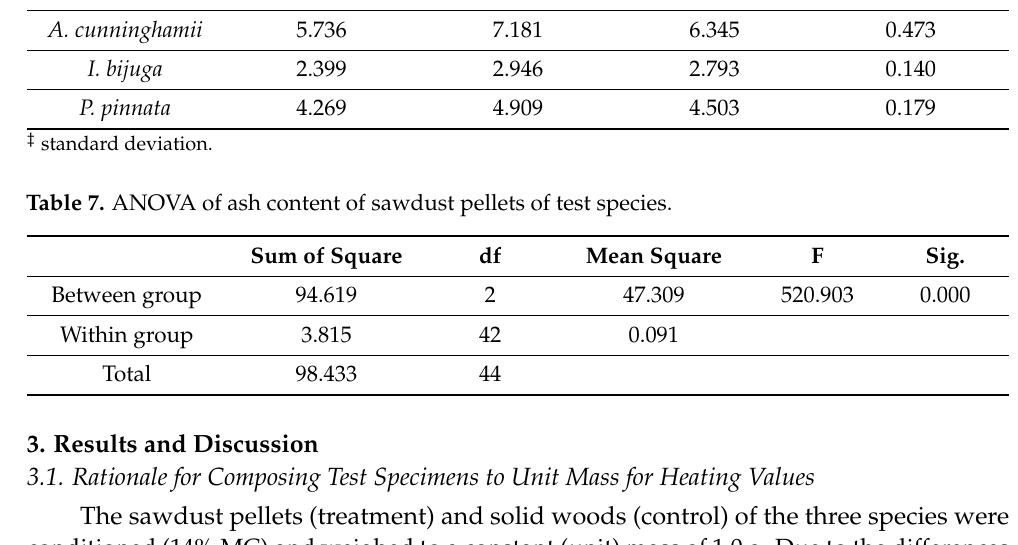
Table 6. Ash content analysis of ash content of sawdust pellets of test species. Statistical Analysis of Ash Contents (%) Test Species Minimum